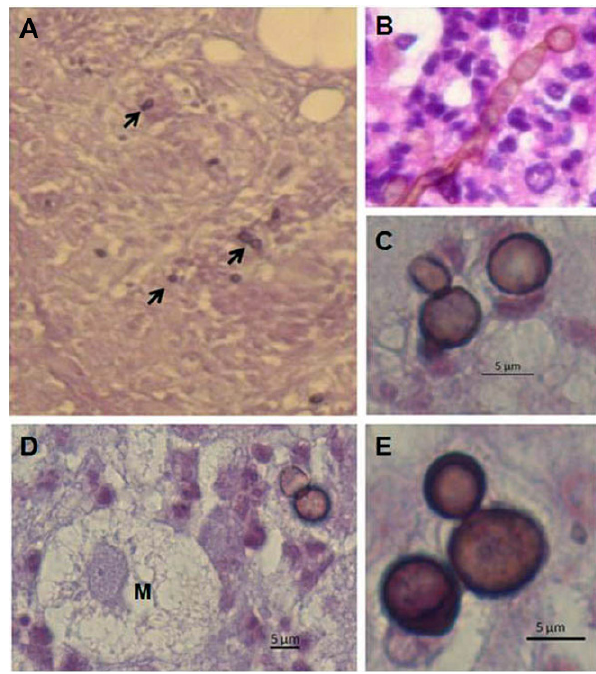
Figure 5. ( A ) Roundish cells observed 20 days after infection of mice with co-culture of F. pedrosoi and B. subtilis ; Brown-Brenn (BB) stain, 100x. ( B ) Terminal chlamydoconidia on hyphae; HE, 400x. ( C ) Brown-roundish cells; BB stain, 1000x. ( D ) Foamy macrophage (M) and brown-roundish cells, BB stain, 400x. ( E ) Proliferation of brown-roundish cells, BB stain,